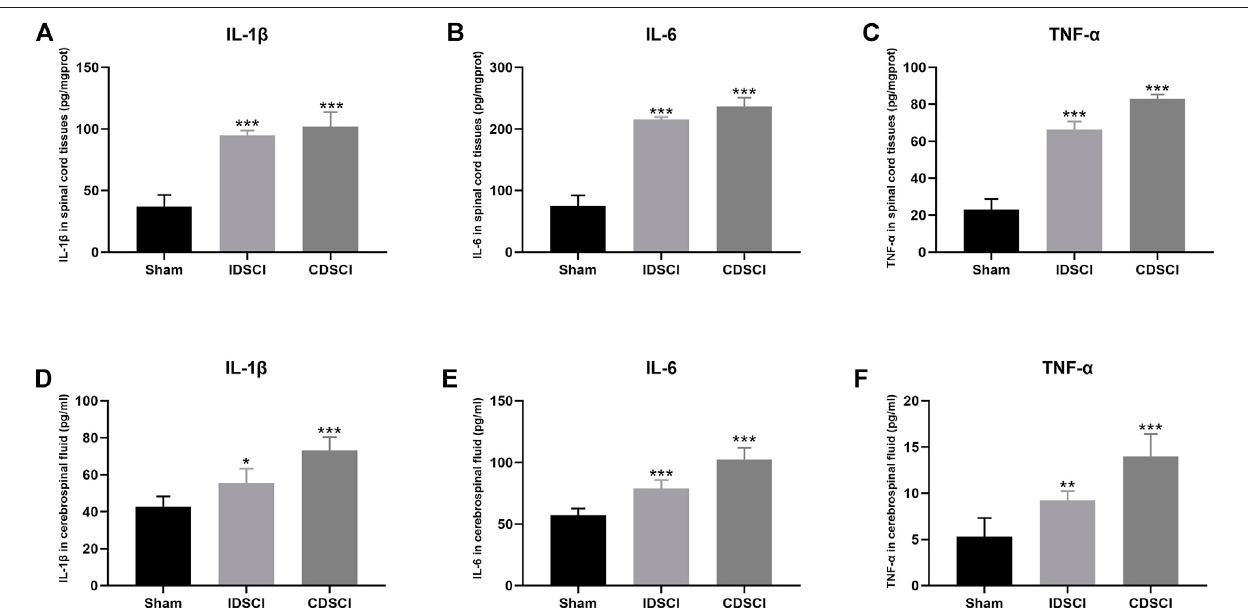
FIGURE 5 | The levels of in fl ammatory cytokines in spinal cord tissues and cerebrospinal fl uid at 7 days after DSCI. (A – C) The levels of IL-1 β , IL-6 and TNF- α in spinalcordtissuesofdifferentgroups. (D – F) TheexpressionofIL-1 β ,IL-6,andTNF- α inCSFofdifferentgroups.Allvaluesareexpressedasmeans±SD.* p < 0.05,** p < 0.01, *** p < 0.001 vs. the sham